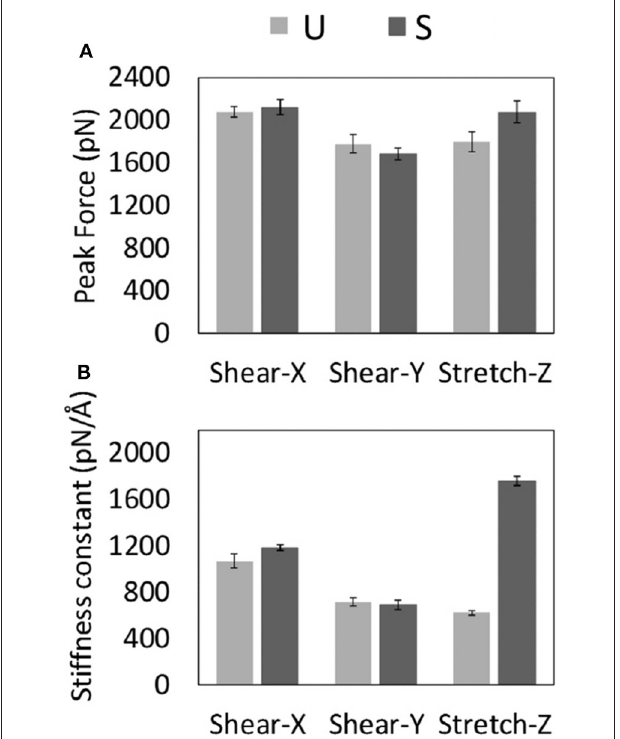
FIGURE 3 | Average values with related standard error of the Peak Forces (A) and Stiffness Constants (B) recorded for U- and S-models during each type of SMD